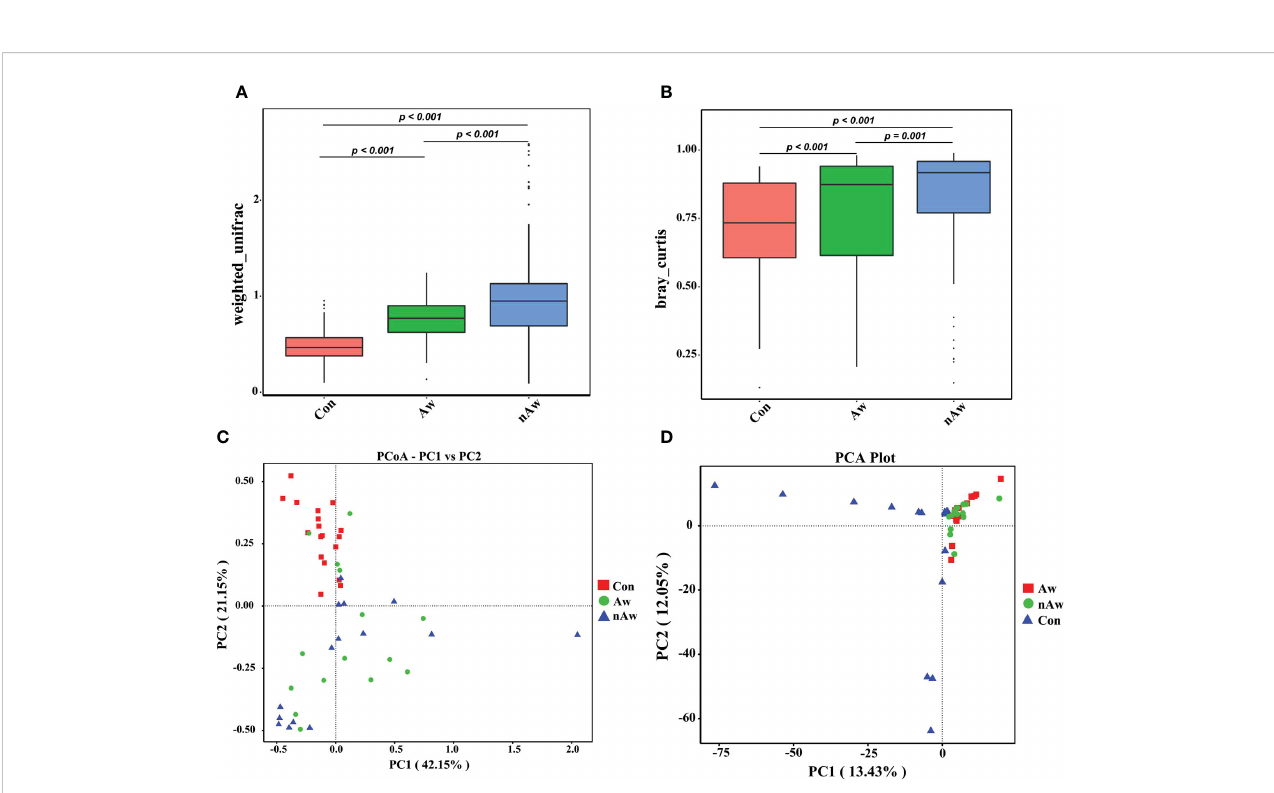
FIGURE 3 Beta-diversity analysis of microbiome in BAL. (A) Beta diversity index based on Weighted Unifrac, (B) Beta diversity index based on Bray_Curtis, (C) Display of Principal Co-ordinates Analysis (PCoA) plots of the samples in two-dimension based on weighted unifrac (PC1 = 42.15%, PC2 = 21.15%), (D) Display of Principal Component Analysis (PCA) of the samples in two-dimension (PC1 = 13.43%, PC2 = 12.05%). Wilcox test was used. Aw, atopic wheezing group; nAw, non-atopic wheezing group; Con, foreign body aspiration infants as controls.